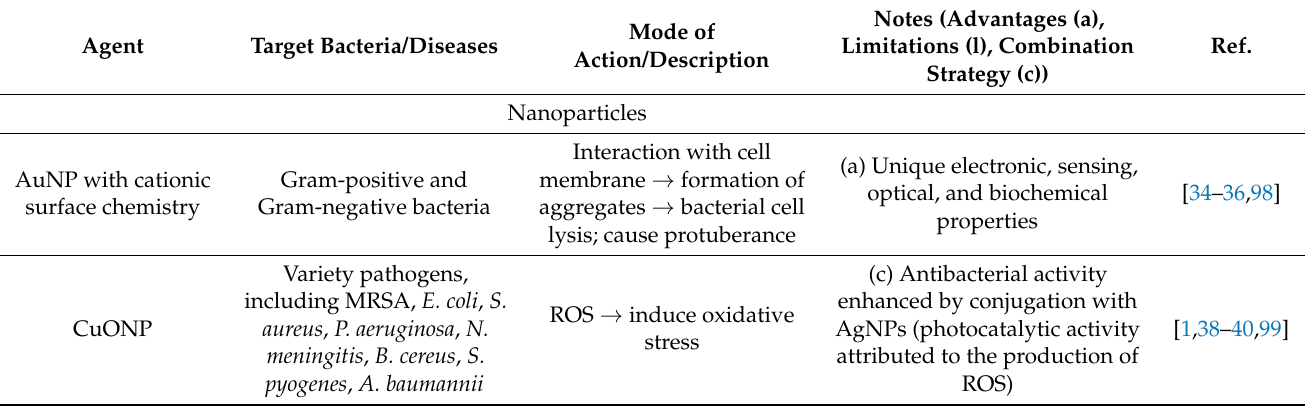
Table 1. Use of different nanoparticles as a weapon against drug-resistant bacteria. Mode Agent Target Bacteria/Diseases